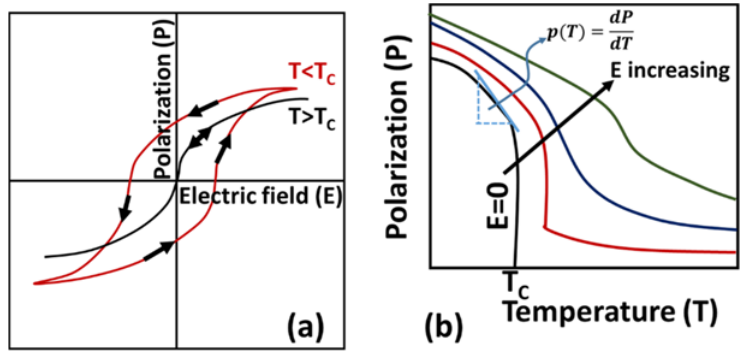
Figure 13. ( a ) Polarization (P) vs. applied electric field (E) responses of a ferroelectric material above and below the Curie temperature, T C . Hysteretic behavior can be seen at temperature below T C ; ( b ) Variation of polarization with respect to temperature at different applied electric fields. The pyroelectric coefficient (gradient of polarization versus temperature, dP near the Curie temperature. Figures reconstructed from ref. [112].